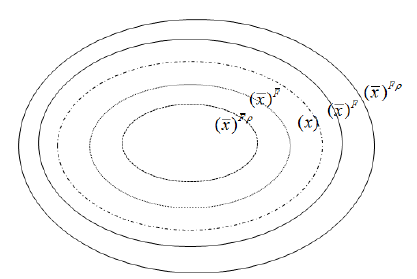
Fig. 1 The relationship among ( x ) , (( ¯ x ) F , ( ¯ x ) ¯ F ) , and (( ¯ x ) F σ , ( ¯ x ) ¯ F σ